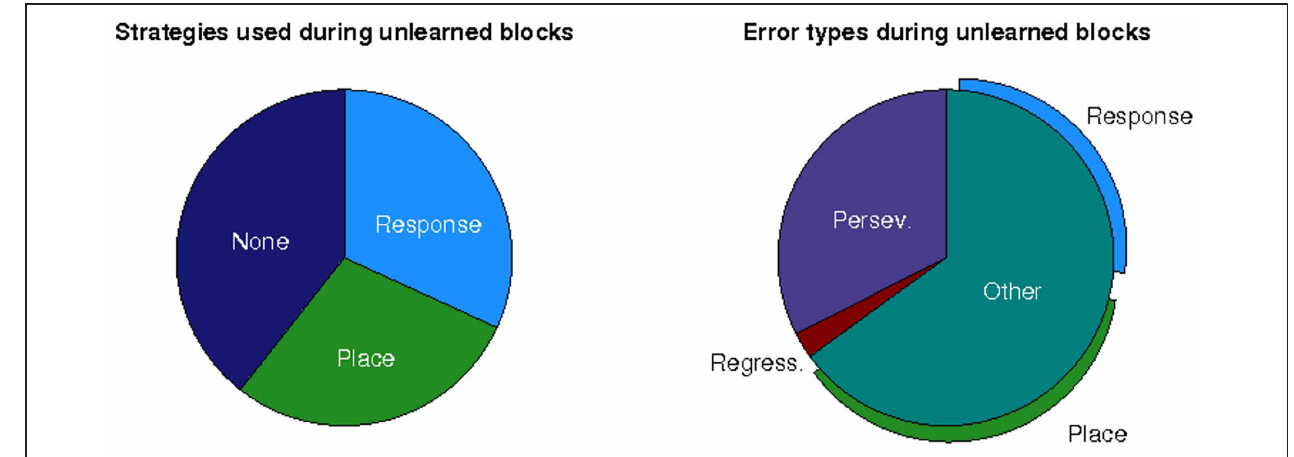
FIGURE 6 | Left: Strategies used during unlearned blocks as a proportion of all unlearned blocks for old participants. Right: Error types made during unlearned blocks as a proportion of all unlearned blocks in which an incorrect strategy was used for old